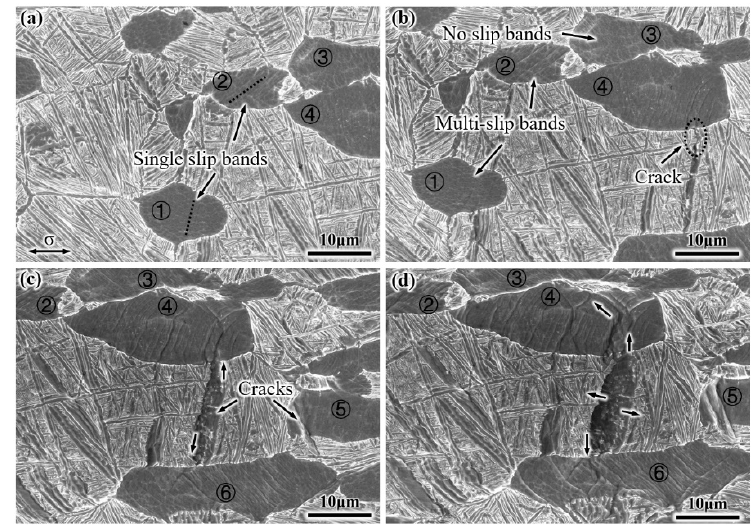
Figure 6. Engineering stress–strain curves for the EM and S-EM after the in situ SEM tensile test. The letters A 1 (A 2 ), B 1 (B 2 ), C 1 (C 2 ), and D 1 (D 2 ) indicate the points at which the test was interrupted for imaging.